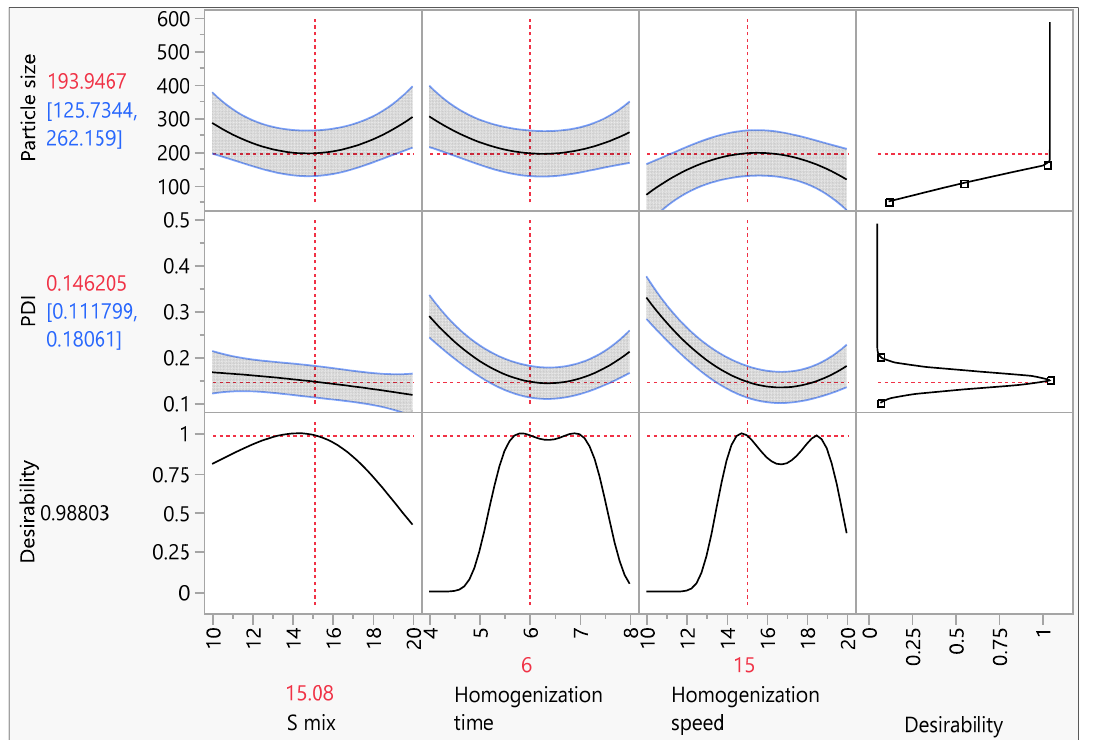
Figure 7. Prediction profile of prepared SLNs where the actual values are similar to that of the predicted